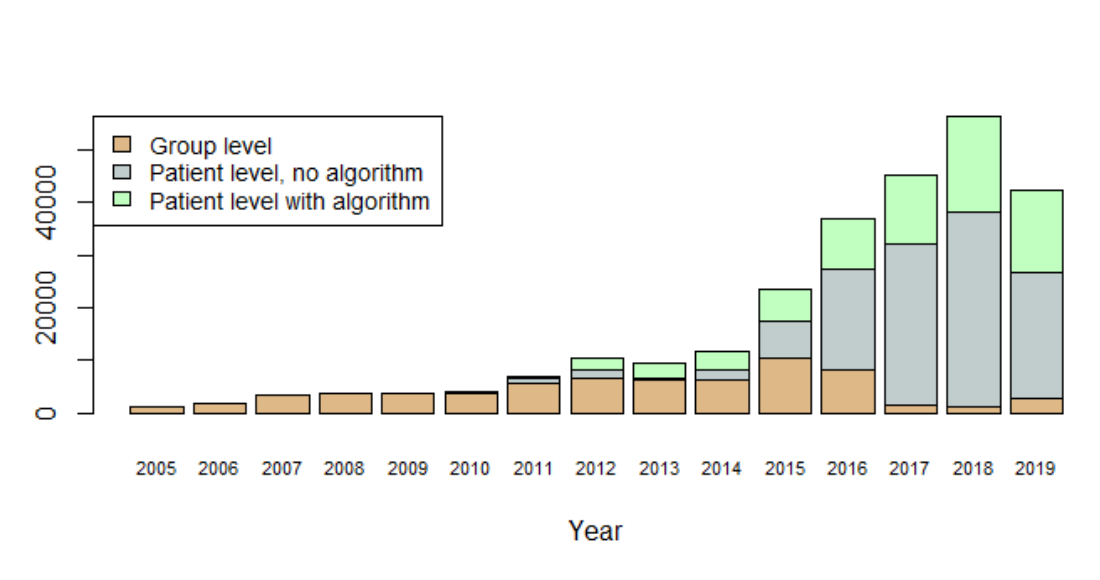
Figure 6. Contact to patients by year, and method for prompting the patients to fill in the